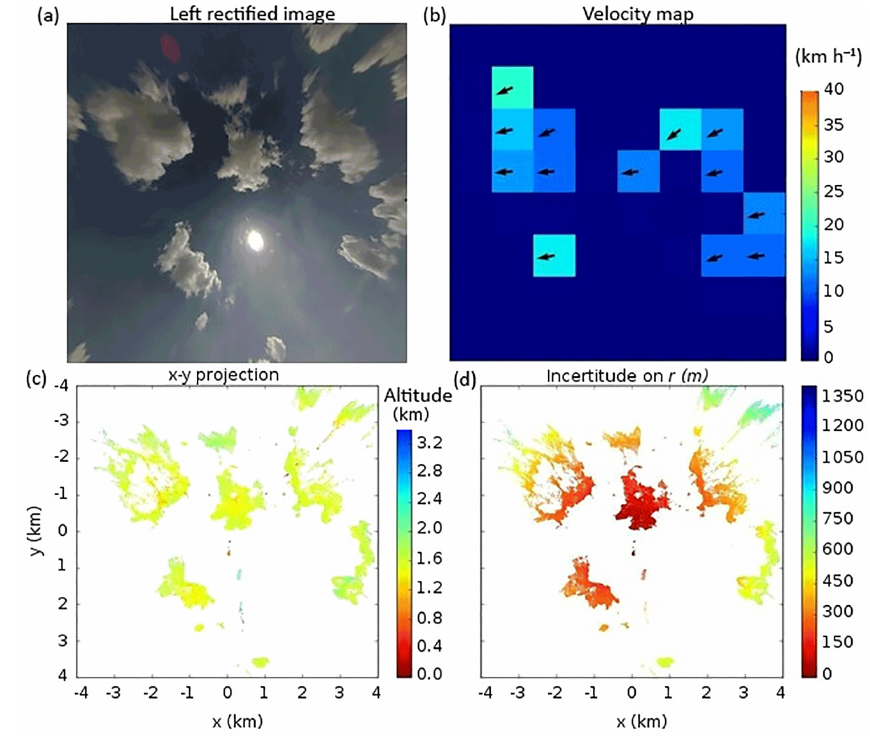
Figure 13. Cumulus case. (a, b) Rectified image (a) with estimated wind speed and direction (b) . (c, d) Triangulated points projected on x − y left camera plane with altitude color map (c) , and with r -incertitude color map (d)